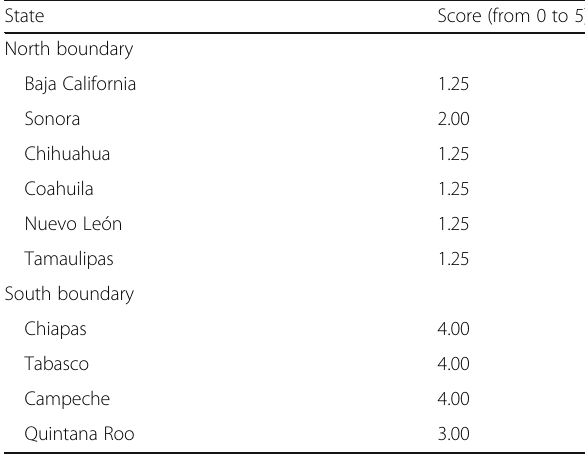
Table 3 Transboundary legal framework indicator for Mexican border states. Source: